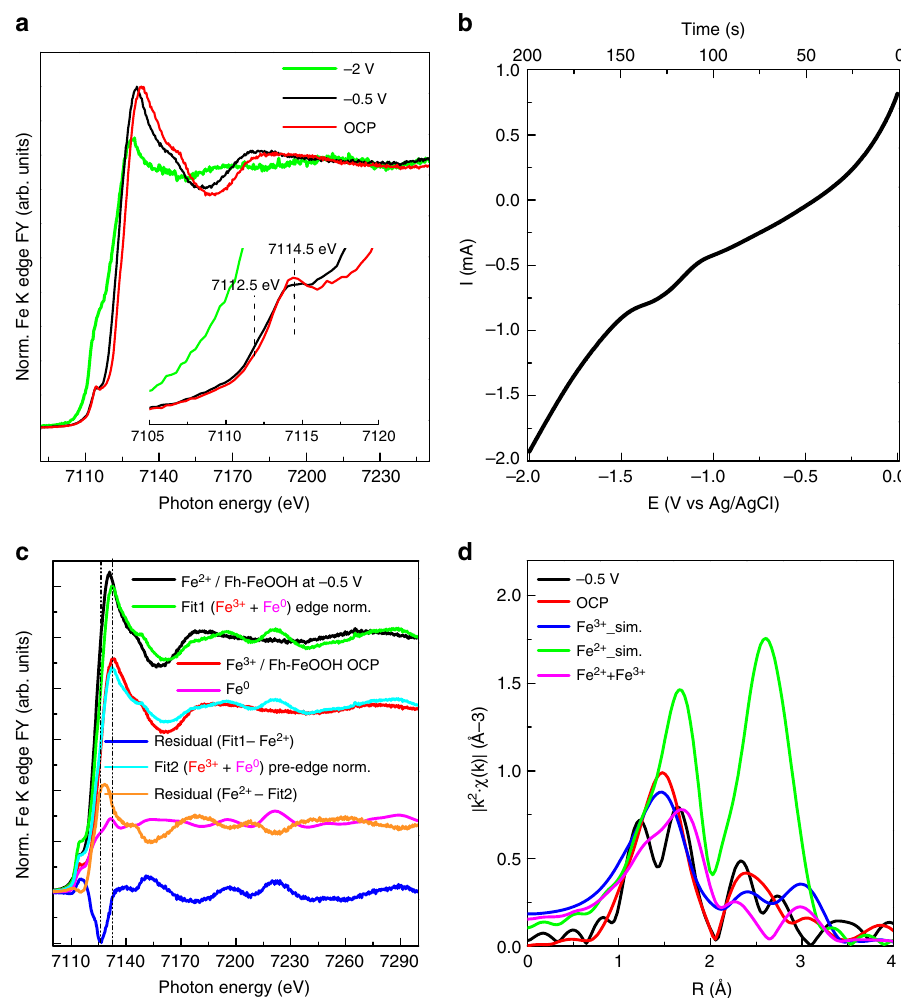
Fig. 7 FY-mode Fe K edge XANES spectra of Fe/N-C during cyclic voltammetry. a FY Fe K edge XANES spectra during cyclic voltammetry and b corresponding voltammogram in the relevant potential region. c Normalized Fe K edge spectra of Fe/N-C at − 0.5 V in 0.05 M KHCO 3 (black line); Fe/N-C at OCP in 0.05 M KHCO 3 component of the fi t (red line); Fe foil component of the fi t (magenta line); Envelope of Fe/N-C at − 0.5 V with Fe (III) component (Fe/N-C at OCP) and Fe 0 component (Fe foil) in Fit 1 (green line); Difference spectrum Fit 1 - Fe/N-C at − 0.5 V (blue line); Fit 1 normalized to the pre-edge in Fe/N-C at − 0.5 V in 0.05 M KHCO 3 (cyan line); Difference spectrum Fe/N-C at − 0.5 V - Fit 2 (orange line). d Fourier transform EXAFS spectra of: Fe/ N-C at − 0.5 V in 0.05 M KHCO 3 (black line); Fe/N-C at OCP in 0.05 M KHCO 3 (red line); simulations of EXAFS signal for Fh -FeOOH (blue line) from (PDF 00-058-0898).cif, wüstite (green line) from (amcsd_0002758) and a mixture of Fh -FeOOH and wüstite 1:1 (magenta line) performed with Artemis software (IFEFFIT package) using Feff6.0 code